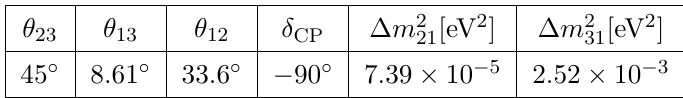
Table 2 . The benchmark values of the oscillation parameters used in our analysis. These values are consistent with the present best-fit values as obtained in various global fit studies [19–22]. We assume normal mass hierarchy (NH) of neutrino throughout this